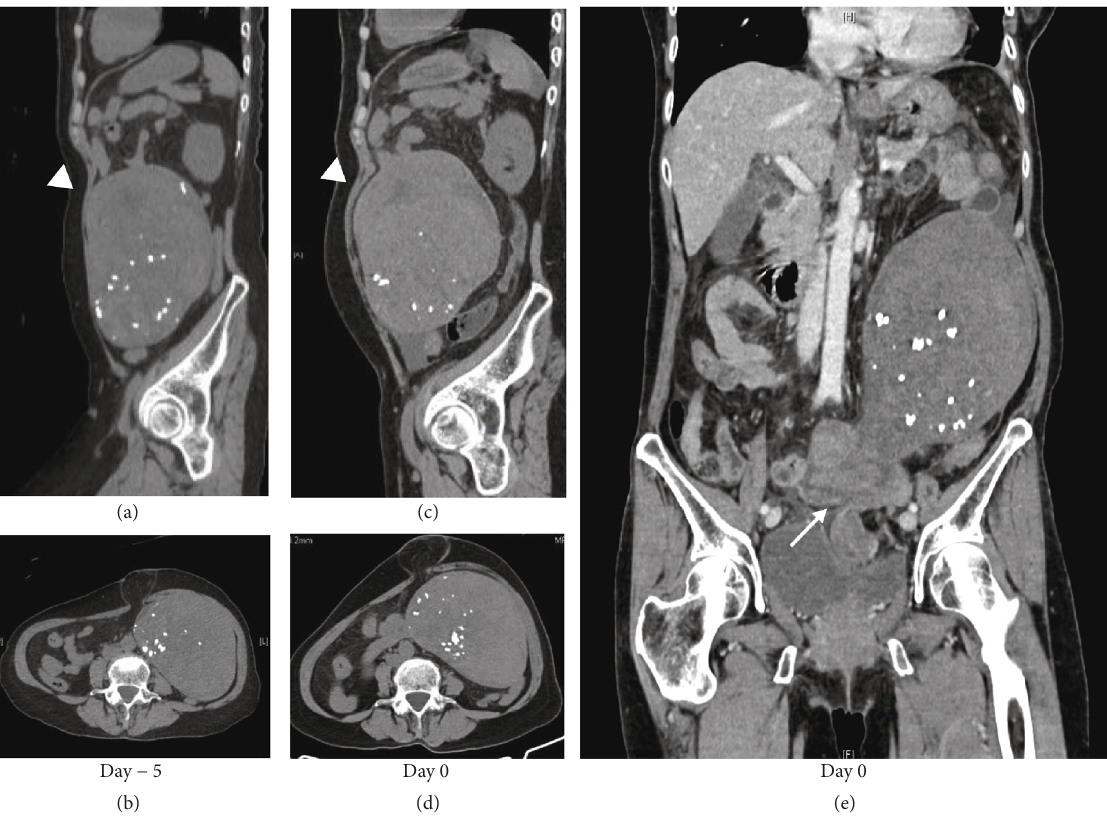
Figure 1: Computed tomography (CT) images of the uterus and leiomyoma. Comparison of sagittal (a, c) and axial (b, d) views of the plain abdominal CT images. Compared to the CT scan taken 5 days before the surgery (a, b), the leiomyoma had slightly enlarged in size and anteriorly deviated (white arrowheads) on the day of emergency surgery (c, d). The enhanced CT image (e) showed a twisted cervix at the level of the uterine body and cervical junction (white